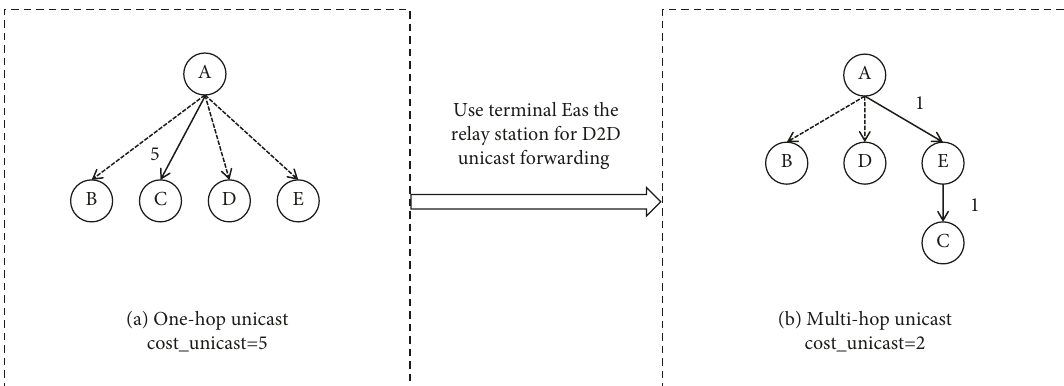
Figure 5: Example of one-hop unicast and multihop unicast. (a) One-hop unicast cost_unicast � 5. (b) Multihop unicast cost_unicast �